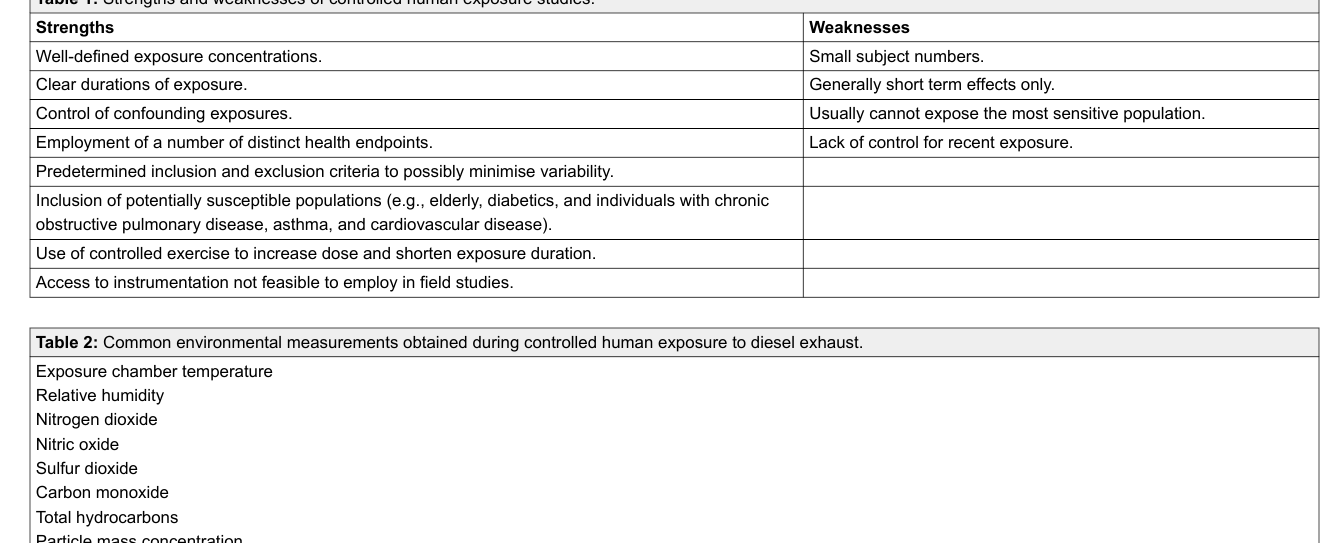
Table 1: Strengths and weaknesses of controlled human exposure studies. Strengths Weaknesses Well-defined exposure concentrations.